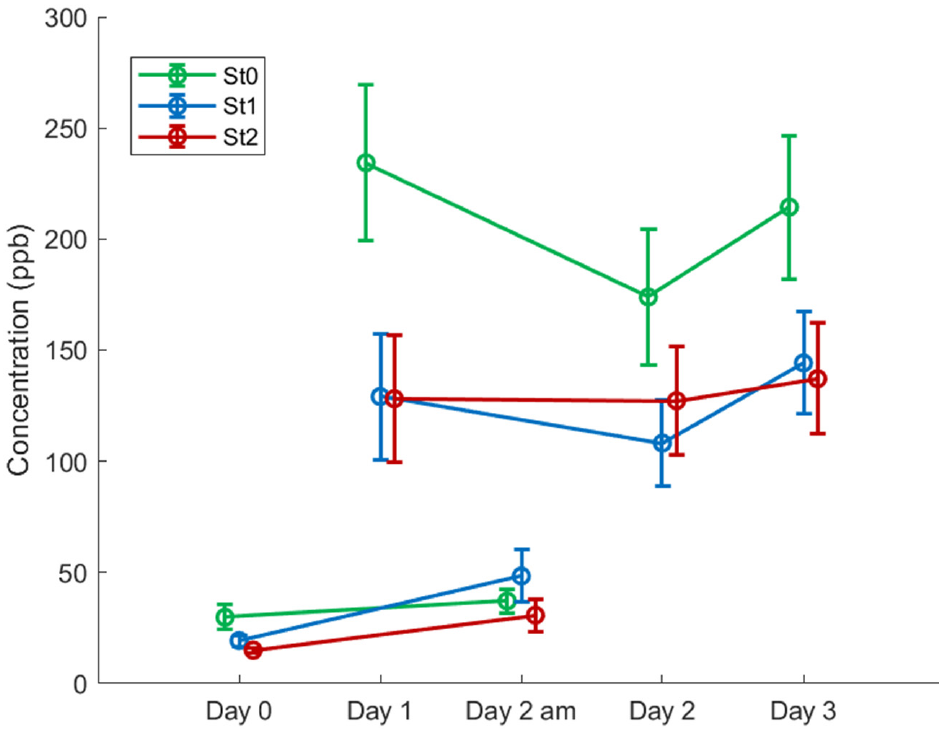
Figure 5. Changes in the concentration of the short-chain fatty acids (SCFAs) cluster over days for each group. Exercise (walking) induced an increase ( p < 0.001) in SCFAs for all the groups (Day 1, Day 2, and Day 3) compared to (Day 0 and Day 2 am). The SCFAs levels were higher for the non-statin group (St0) compared to statin users (St1: p = 0.013 and St2: p = 0.005). No difference between St1 and St2 over the post-walking period ( p = 0.2843). For St0, the SCFAs concentration reached baseline level ( p = 0.08), whilst for St1 ( p = 0.009) and St2 ( p = 0.007), the SCFAs concentration was elevated after a period of rest compared to Day 0. Concentration values are presented as mean ± standard